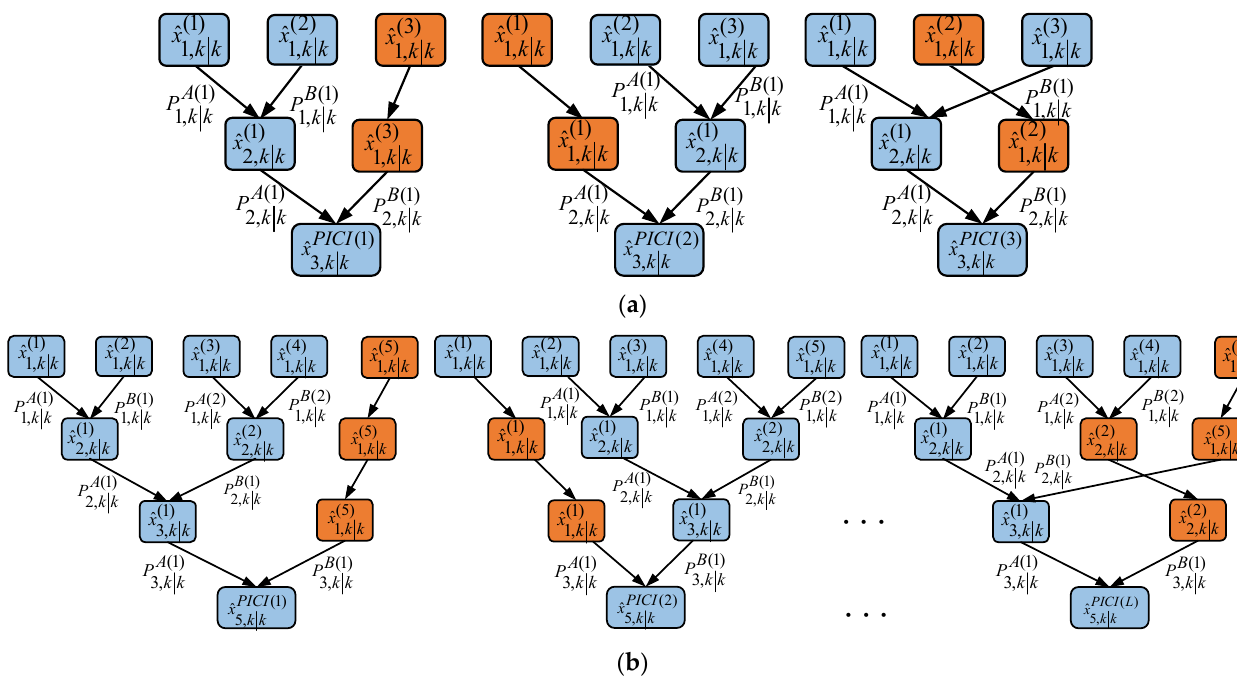
Figure 5. Comparison results of different covariance intersection fusion algorithms; ( a ) 3-sensor PICI fusion, ( b ) 5-sensor PICI fusion.